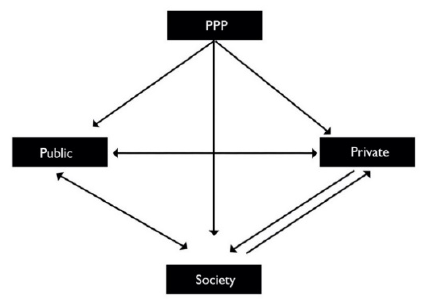
Figure 1. PPP Relationship between Stakeholders. Adapted from [23].